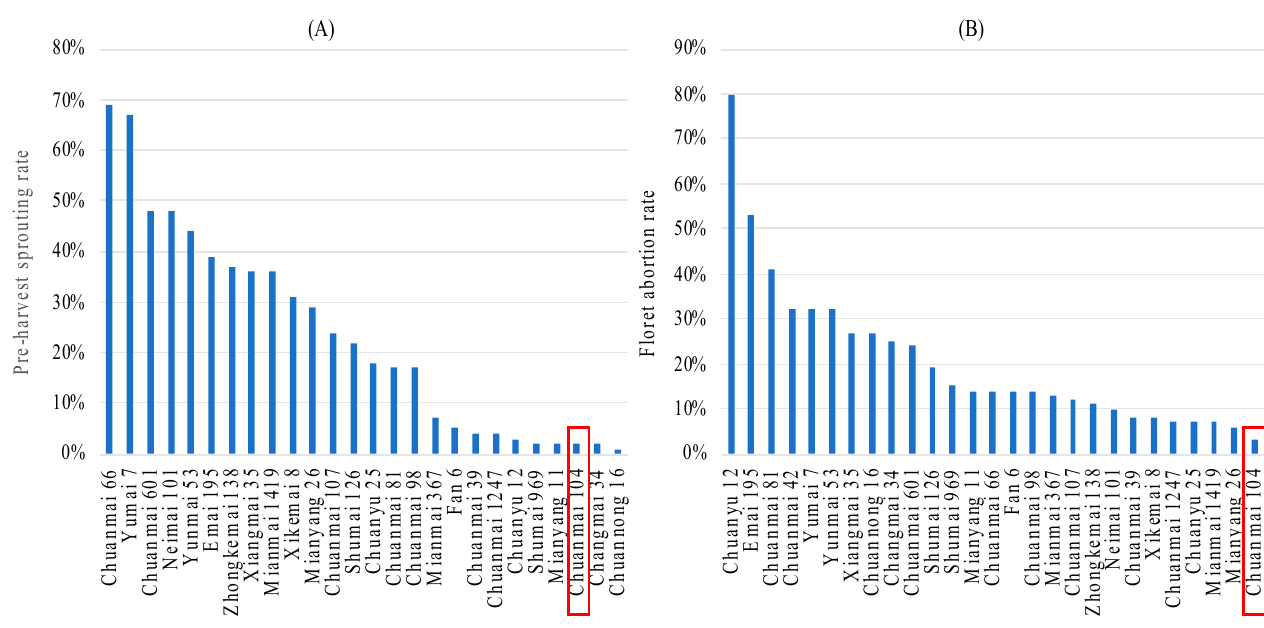
Figure 6. Pre-harvest sprouting ( A ) and low temperature ( B ) tolerance of Chuanmai 104 Chuanmai 104 was listed as the leading commercial cultivar for wheat production by the Sichuan Province government from 2013 to 2016 and the Ministry of Agriculture and Rural Affairs of China from 2015 to 2016. From 2015 to present, a total of 11 cultivars were selected from crosses involving Chuanmai 104, such as the big-spike cultivar Chuanmai 93 and tight-plant-type cultivar Chuanmai 98; generally, Chuanmai 104 has also been used as a foundation parent for recent wheat breeding (Table 4). Since 2012, the planting acre- age of Chuanmai 104 has totaled 21.5 million mu and generated an additional economic output of 2.4 billion Chinese yuan [53]. The breeding and application of Chuanmai 104